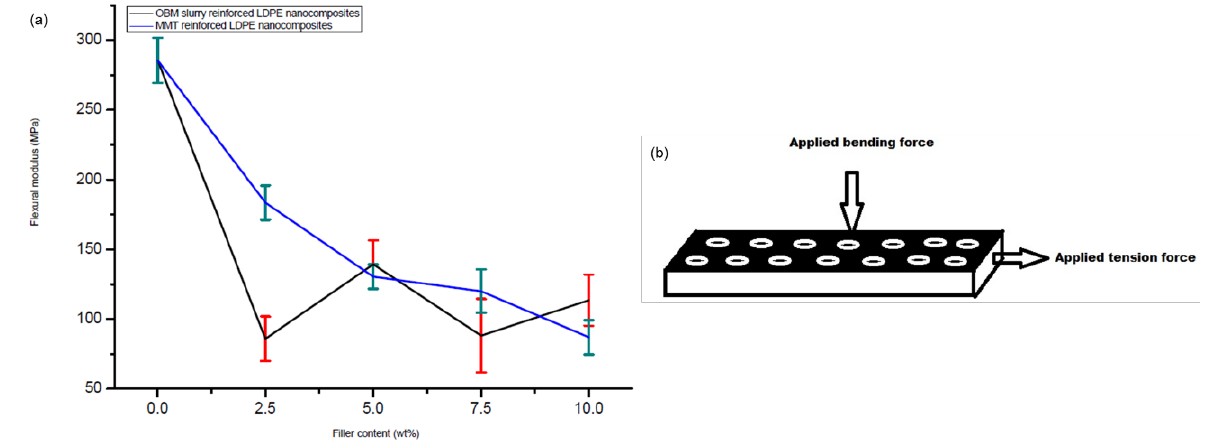
Figure 14. ( a ) Comparison of modulus of elasticity in bending of neat LDPE, LDPE/MMT and LDPE/OBM slurry nanocomposites; ( b ) a schematic illustration of applied force in tension and bending test and the distribution of MMT and OBM slurry nanoplatelets through the sample.